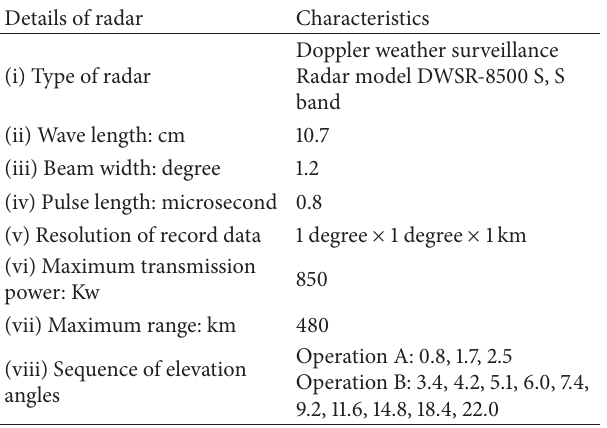
Table 2: Characteristics of radar at Pimai station, Nakhon Ratchas- ima